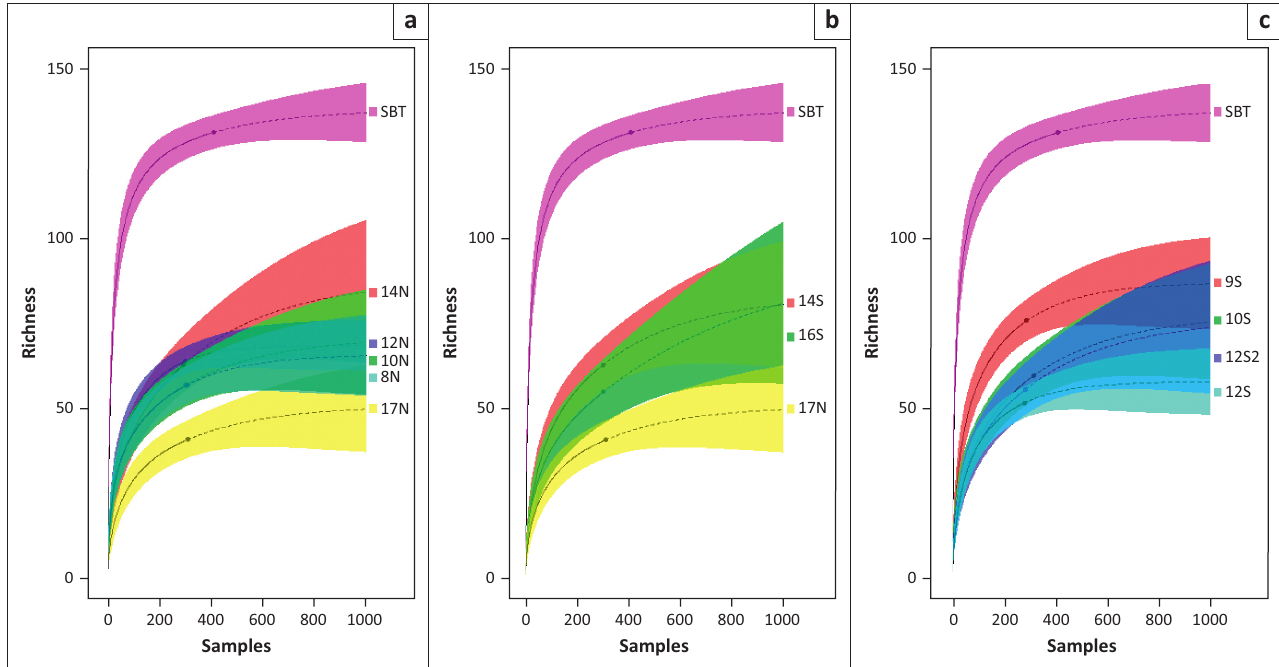
FIGURE 5: Species accumulation curves and their 95 % confidence intervals for 1000 samples per site. The solid circles represent reference samples; solid lines are rarefied samples and dashed lines are extrapolation based on Mau Tau estimation. (a) Northern aspect, (b) higher elevational sites and (c) low to mid-elevation southern aspect. SBT, accumulation curve for the whole transect.